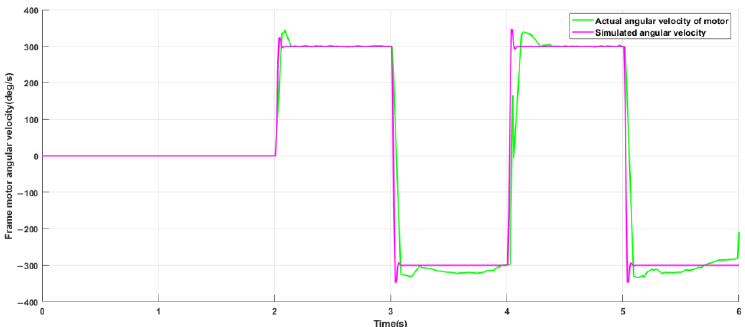
Figure 10. Plot of transfer function versus actual motor output for the same target angular velocity. Table 5. Control parameters of the simulation.